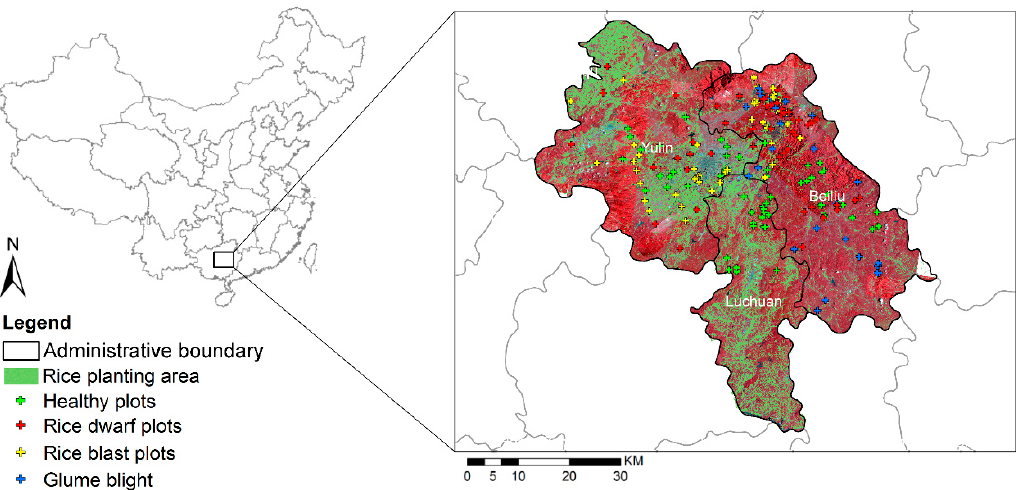
Figure 1. A false-color map of study areas and survey plots in Guangxi Province, China. The rice planting areas are revealed as green polygons.